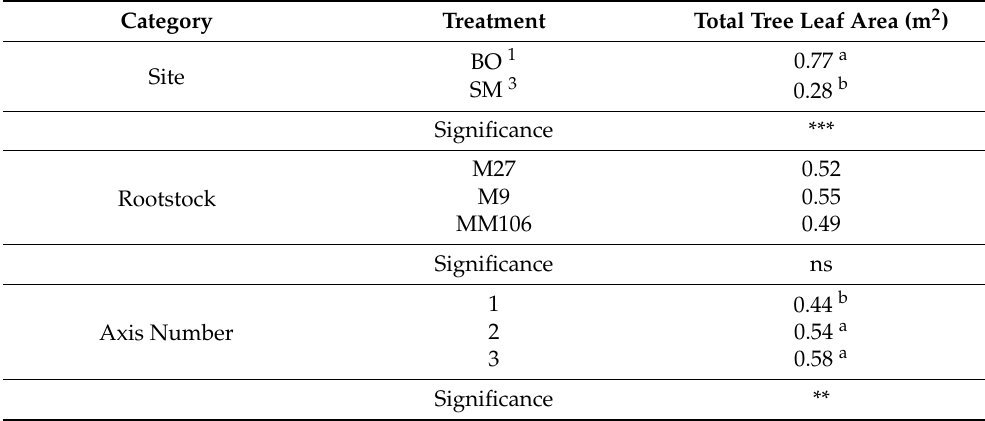
Table 3. Main effects of site of cultivation, rootstock, and axis number on total tree leaf area in ‘Fuji’ scions. Interactions are not included due to non-significant results across all